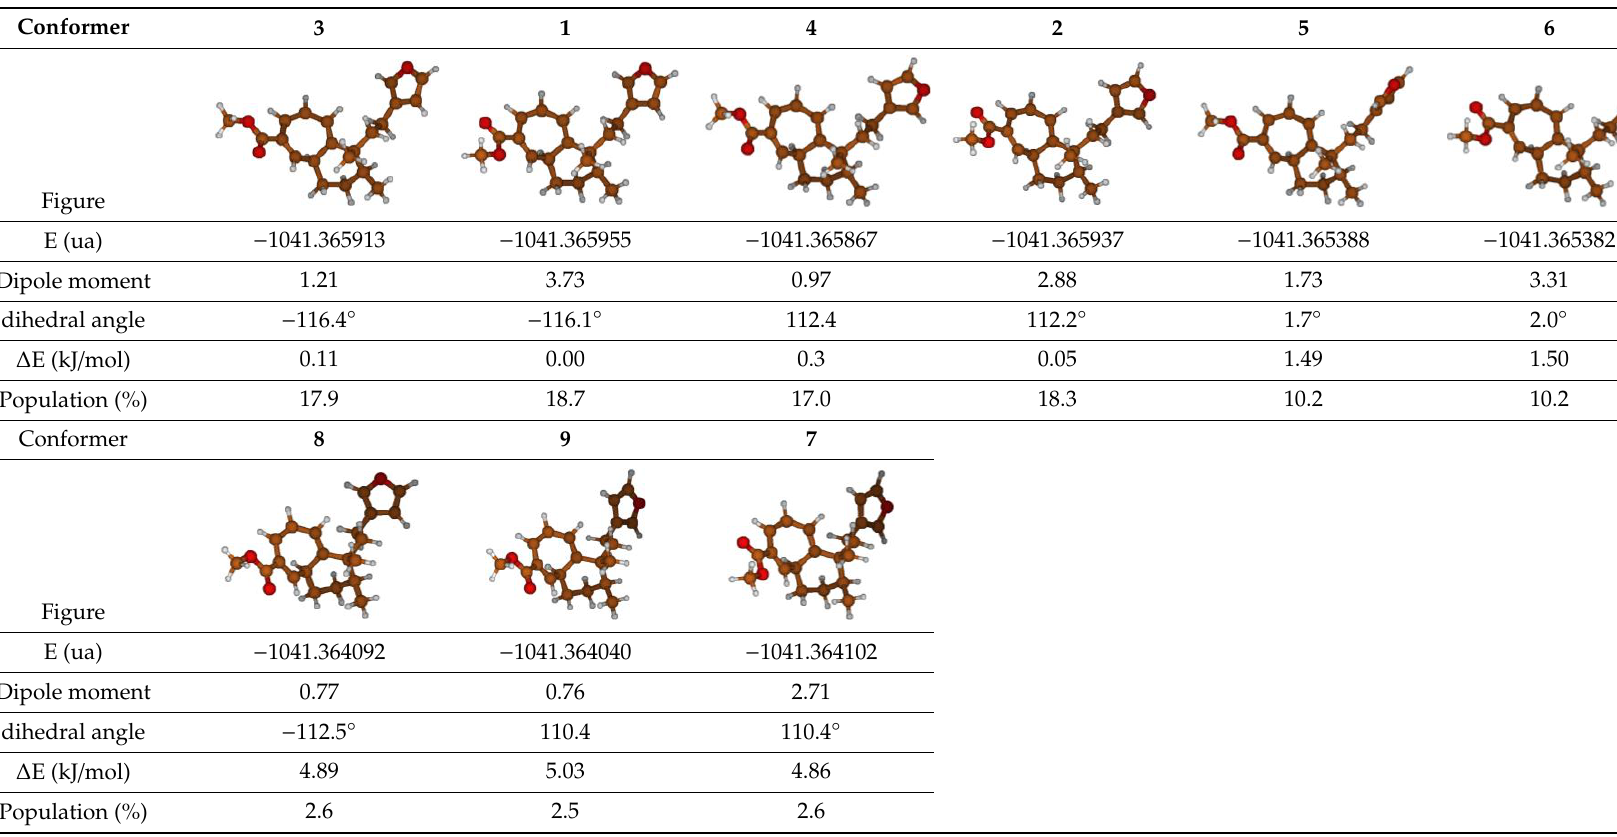
Table 9. Calculated B3LYP / 6-311 + G(d,p) Energies a , Dipole moments (Debye), relatives Energies a , (C13-C14-C15-C18) dihedral angle, equilibrium population at 25 ◦ C Table 9. Calculated B3LYP/6-311+G(d,p) Energies a , Dipole moments (Debye), relatives Energies a , (C13-C14-C15-C18) dihedral angle, equilibrium population at Table 9. Calculated B3LYP/6-311+G(d,p) Energies a , Dipole moments (Debye), relatives Energies a , (C13-C14-C15-C18) dihedral angle, equilibrium population at Table 9. Calculated B3LYP/6-311+G(d,p) Energies a , Dipole moments (Debye), relatives Energies a , (C13-C14-C15-C18) dihedral angle, equilibrium population at Table 9. Calculated B3LYP/6-311+G(d,p) Energies a , Dipole moments (Debye), relatives Energies a , (C13-C14-C15-C18) dihedral angle, equilibrium population at Table 9. Calculated B3LYP/6-311+G(d,p) Energies a , Dipole moments (Debye), relatives Energies a , (C13-C14-C15-C18) dihedral angle, equilibrium population at Table 9. Calculated B3LYP/6-311+G(d,p) Energies a , Dipole moments (Debye), relatives Energies a , (C13-C14-C15-C18) dihedral angle, equilibrium population at and figures of conformations 1-9 of the 1 S , 8 R , 9 S isomer of methyl iso-dodovisate A ( 3 ). 25°C and figures of conformations 1-9 of the 1 S , 8 R , 9 S isomer of methyl iso-dodovisate A ( 3 ). 25°C and figures of conformations 1-9 of the 1 S , 8 R , 9 S isomer of methyl iso-dodovisate A ( 3 ). 25°C and figures of conformations 1-9 of the 1 S , 8 R , 9 S isomer of methyl iso-dodovisate A ( 3 ). 25°C and figures of conformations 1-9 of the 1 S , 8 R , 9 S isomer of methyl iso-dodovisate A ( 3 ). Table 9. Calculated B3LYP/6-311+G(d,p) Energies a , Dipole moments (Debye), relatives Energies a , (C13-C14-C15-C18) dihedral angle, equilibrium population Table 9. Calculated B3LYP/6-311+G(d,p) Energies a , Dipole moments (Debye), relatives Energies a , (C13-C14-C15-C18) dihedral angle, equilibrium population at Table 9. Calculated B3LYP/6-311+G(d,p) Energies a , Dipole moments (Debye), relatives Energies a , (C13-C14-C15-C18) dihedral angle, equilibrium population at 25°C and figures of conformations 1-9 of the 1 S , 8 R , 9 S isomer of methyl iso-dodovisate A ( 3 ). 25°C and figures of conformations 1-9 of the 1 S , 8 R , 9 S isomer of methyl iso-dodovisate A ( 3 ).